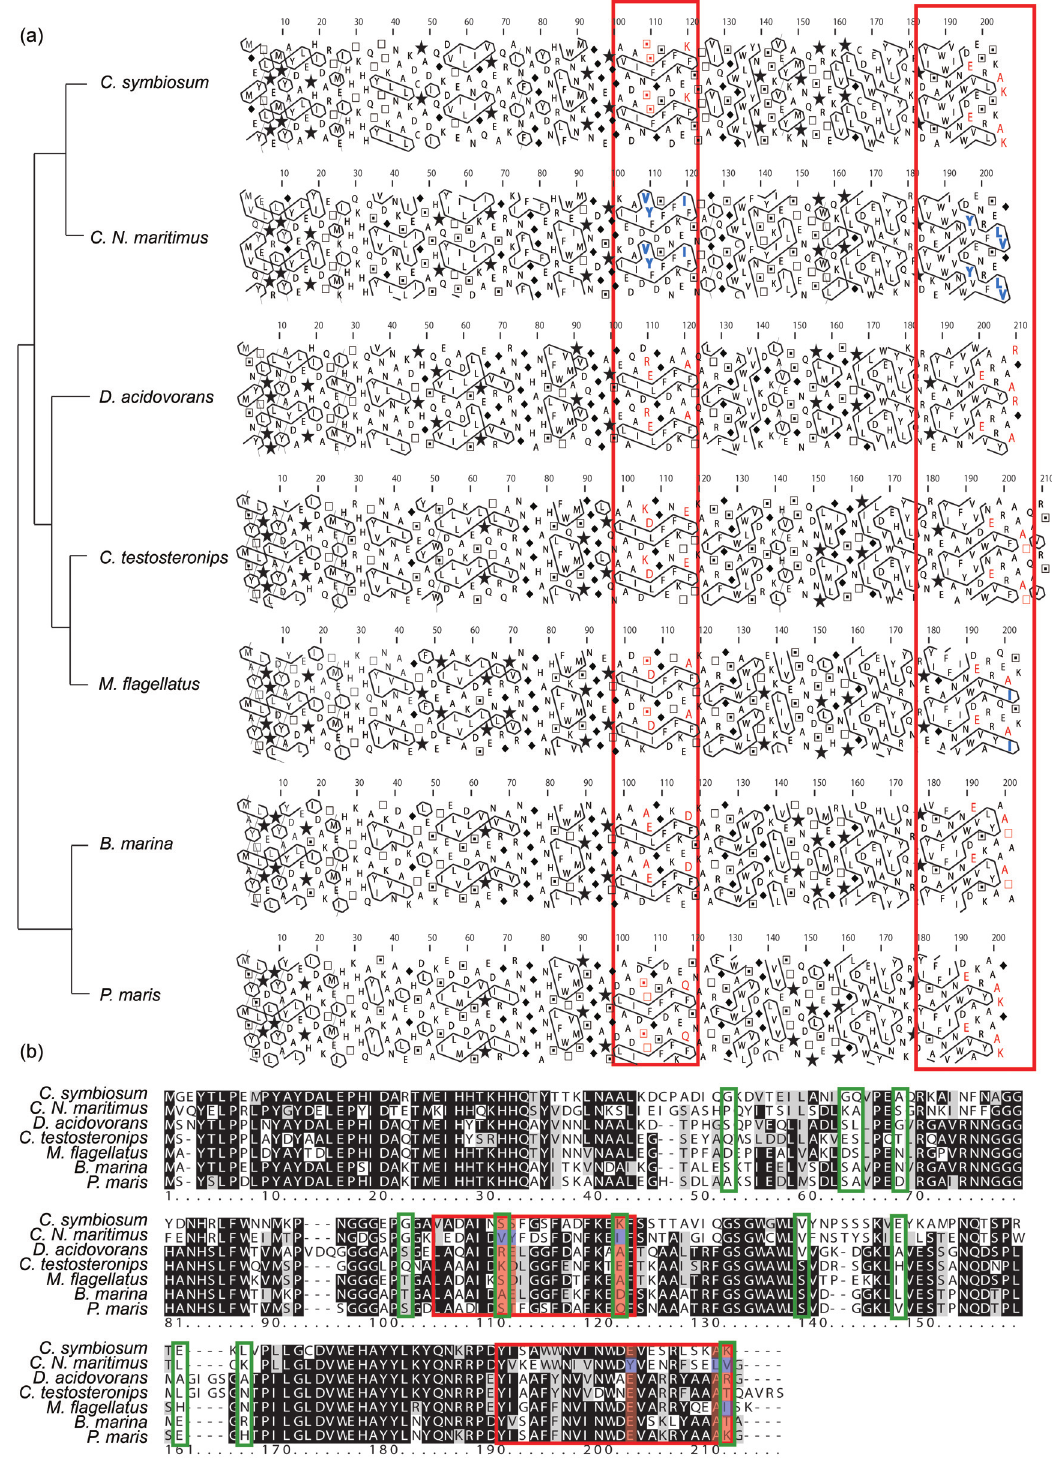
Figure 4 - Comparison of the HCA structure and amino acid sequence of seven MnSODs from the groups Archaea, beta-Proteobacteria and Planctomycetes. Note: A variety of amino acid changes among similar HCA analyses. (A) HCA plot of MnSOD. The vertical red boxes show regions of significant differences based on HCA. Amino acid changes resulting in changes in the HCA plot are in red (hydrophilic) or blue (hydrophobic). The phylogram to the left indicates the likely evolutionary relationship of the taxa in order to compare with changes in hydrophobicity. (B) Amino acid se- quencedalignmentofMnSOD.Theblackbackgroundshowsregionswheretwoormoreaminoacidsaretotallyidentical,whilethegraybackgroundindi- cateschangesresultinginsimilaraminoacids.Thepositionsinred(hydrophilic)orblue(hydrophobic)backgroundshowchangesinhydrophobicity.The redhorizontalboxesencloseregionscorrespondingtotheregionsenclosedbytheverticalboxesinA.Thegreenboxesenclosethepositivelyselectedres- idues detected by PAML in Table